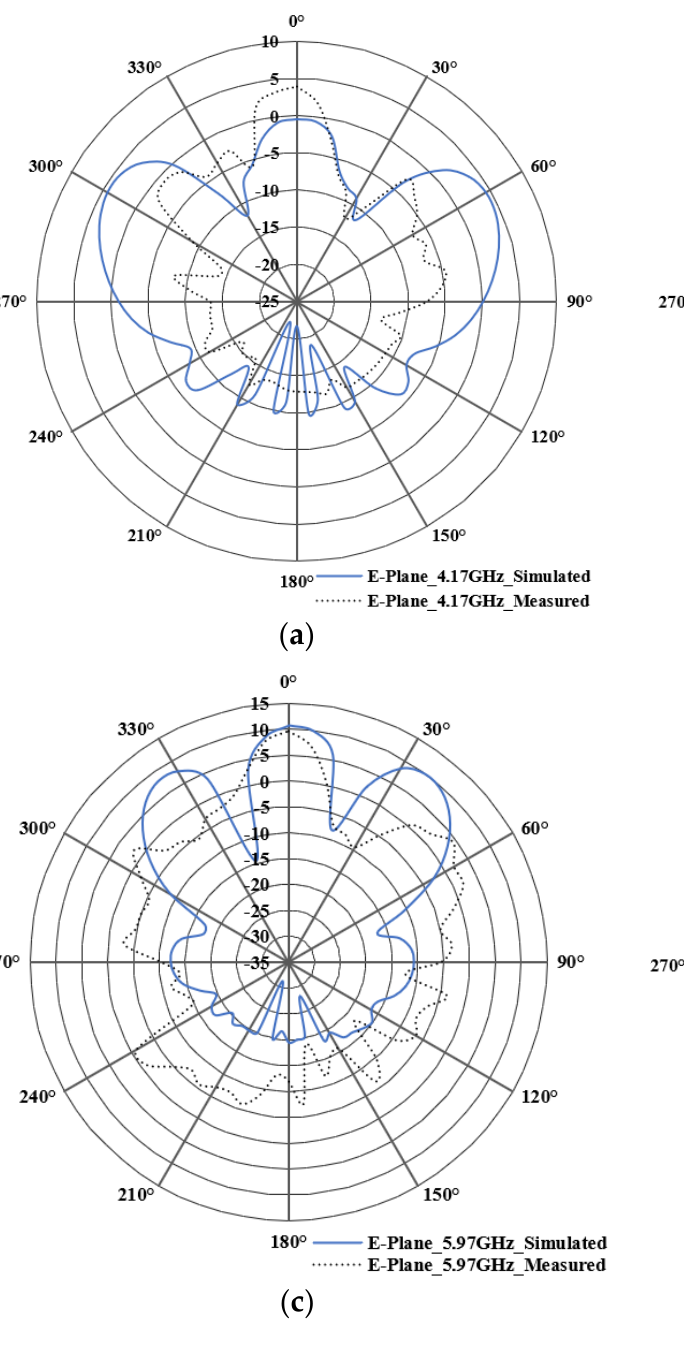
Figure 9. Shows simulated and measured ( a ) E − plane 2D radiation pattern at 4.17 GHz, ( b ) H − plane 2D radiation pattern at 4.17 GHz, ( c ) E-plane 2D radiation pattern at 5.97 GHz, and ( d ) H − plane 2D radiation pattern at 5.97 GHz, respectively, for the four − element MSFAA.